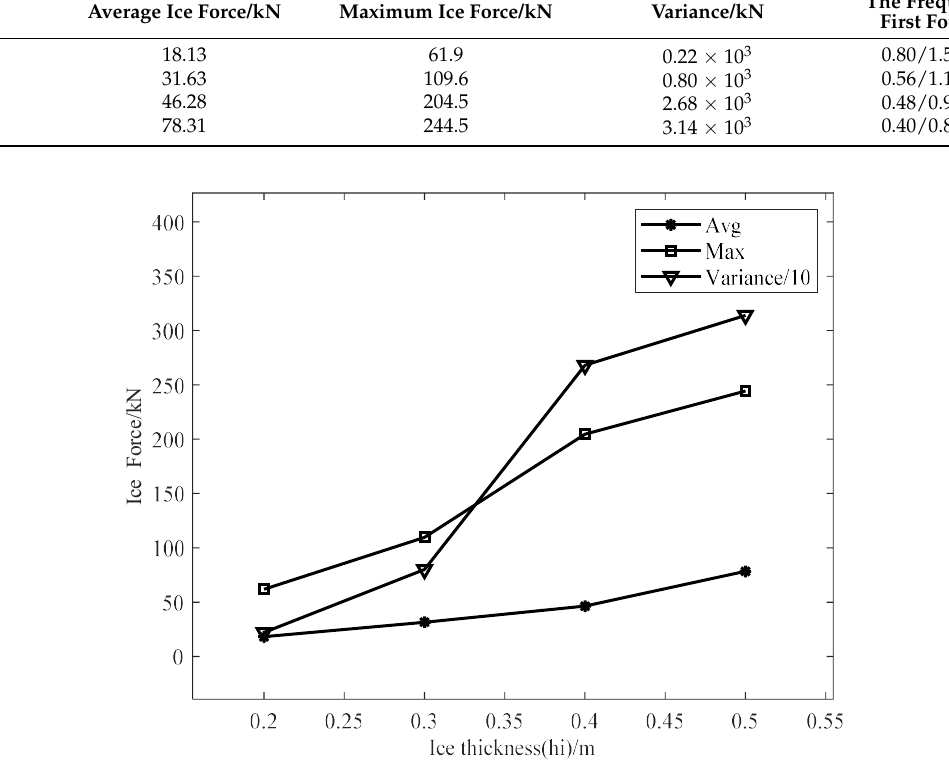
Figure 18. Change trend of variance and ice force with ice thickness (hi).